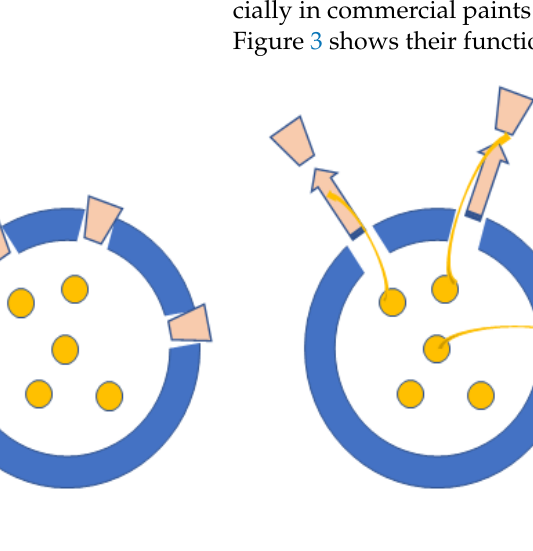
Figure 3. Nanovalves sensitive to pH incorporated onto the surface of silica nanocontainers.